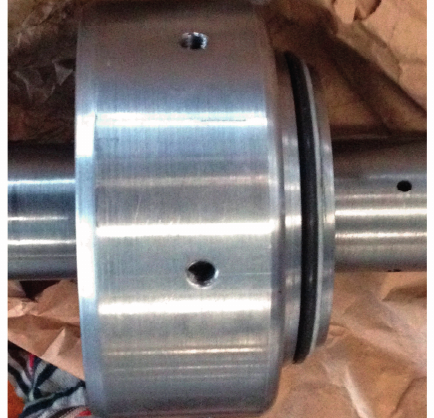
Figure 3. Hydraulic piston with T-shaped